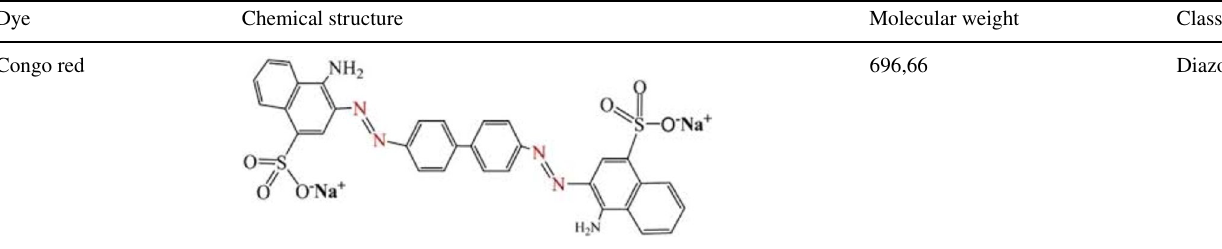
Table 1 The characteristics of Congo red dye Dye Chemical